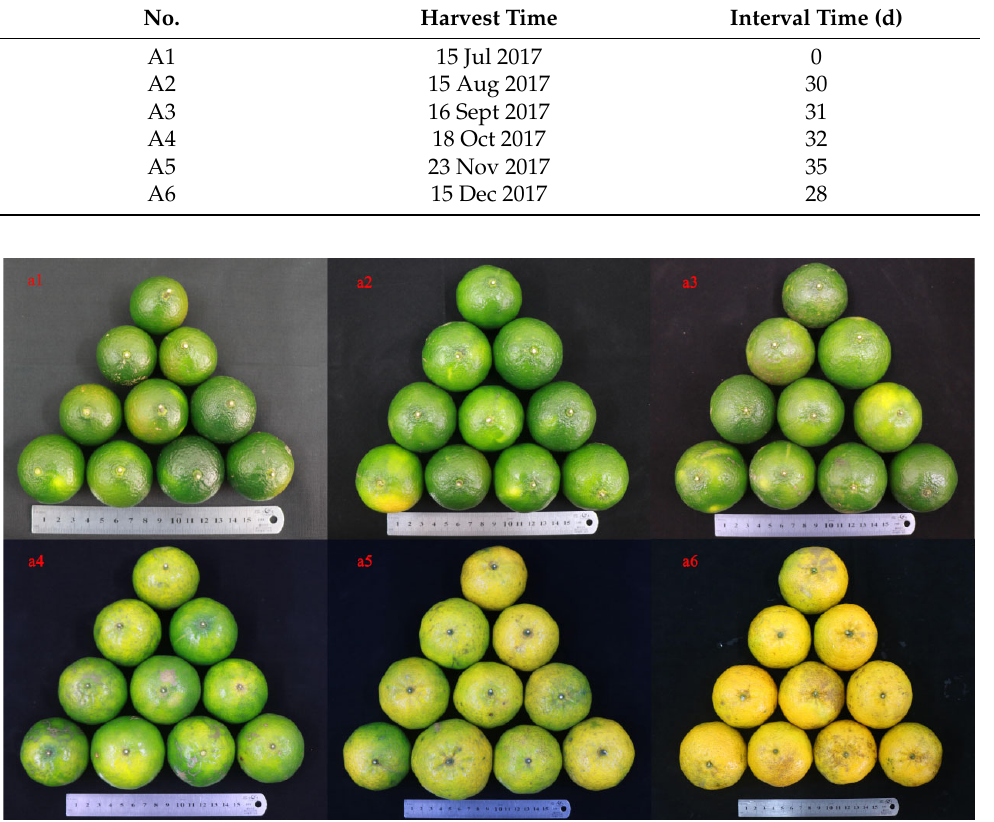
Figure 13. Fresh fruits of Citrus reticulata “Chachi” at different harvest times. The plots represent the following: ( a1 ) fruit harvested in July is dark green; ( a2 ) fruit harvested in August is green; ( a3 ) fruit harvested in September is green; ( a4 ) fruit harvested in October is yellowish; ( a5 ) fruit harvested in November is light yellow; ( a6 ) fruit harvested in December is golden Table 7. Information about PCR samples.